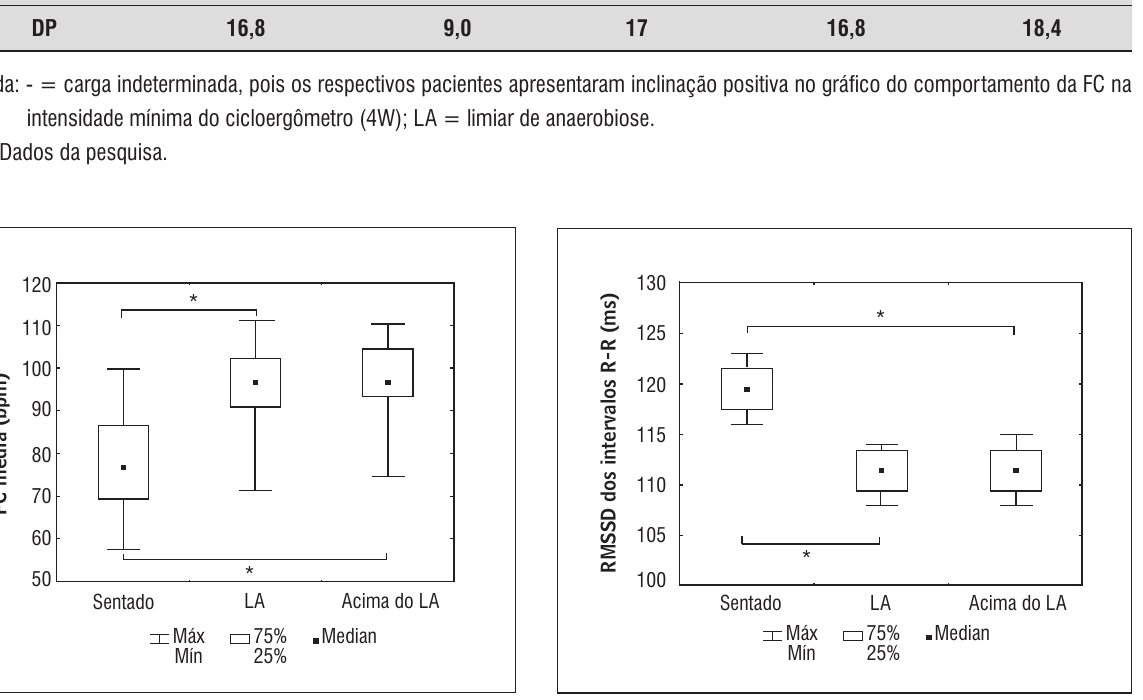
Figura 1 - Valores de FCMed (bpm) obtidos em repouso sen- tado, nas intensidades do LA e acima do LA